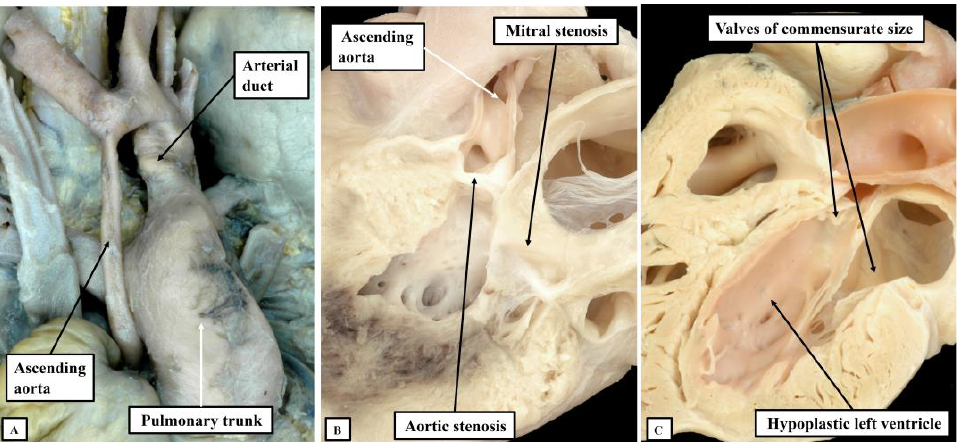
Figure 6. The images show the morphological features underscoring the notion that the hypoplastic left heart syndrome represents an acquired disease of fetal life, reflecting the time after the completion of ventricular septation that the left ventricle stopped its normal growth. Panel ( A ) shows the thread-like ascending aorta found when the aortic root is atretic. Panels ( B ) shows the larger aortic root found when the mitral valve is stenotic and the aortic valve is an imperforate shelf, with panel ( C ) showing the particularly well-formed root seen in the setting of the so-called hypoplastic left heart